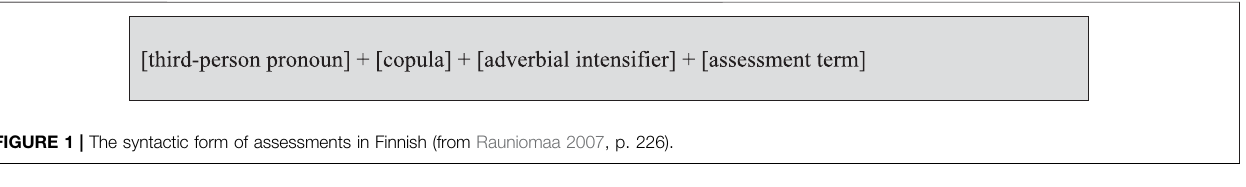
Frontiers in Communication |